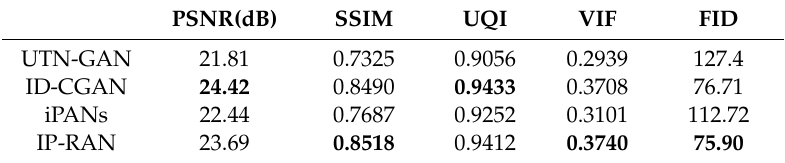
Figure 9. Sample results of synthetic test images. For good visual comparison, the smaller images below the test images represent specific regions-of-interest. ( a ) input images, ( b ) results of UTN-GAN, ( c ) results of ID-CGAN, ( d ) results of iPANs and ( e ) results of the IP-RAN. Table 6. Quantitative results of image de-raining, bold results show good